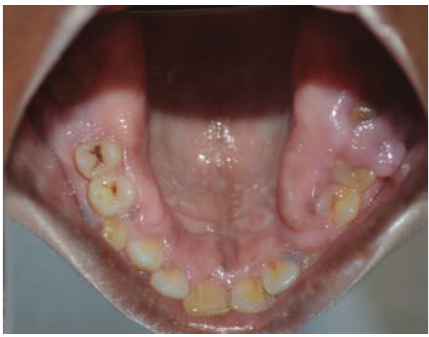
Figure 1: Clinical picture of 14-year-old female with gingival enlargement.